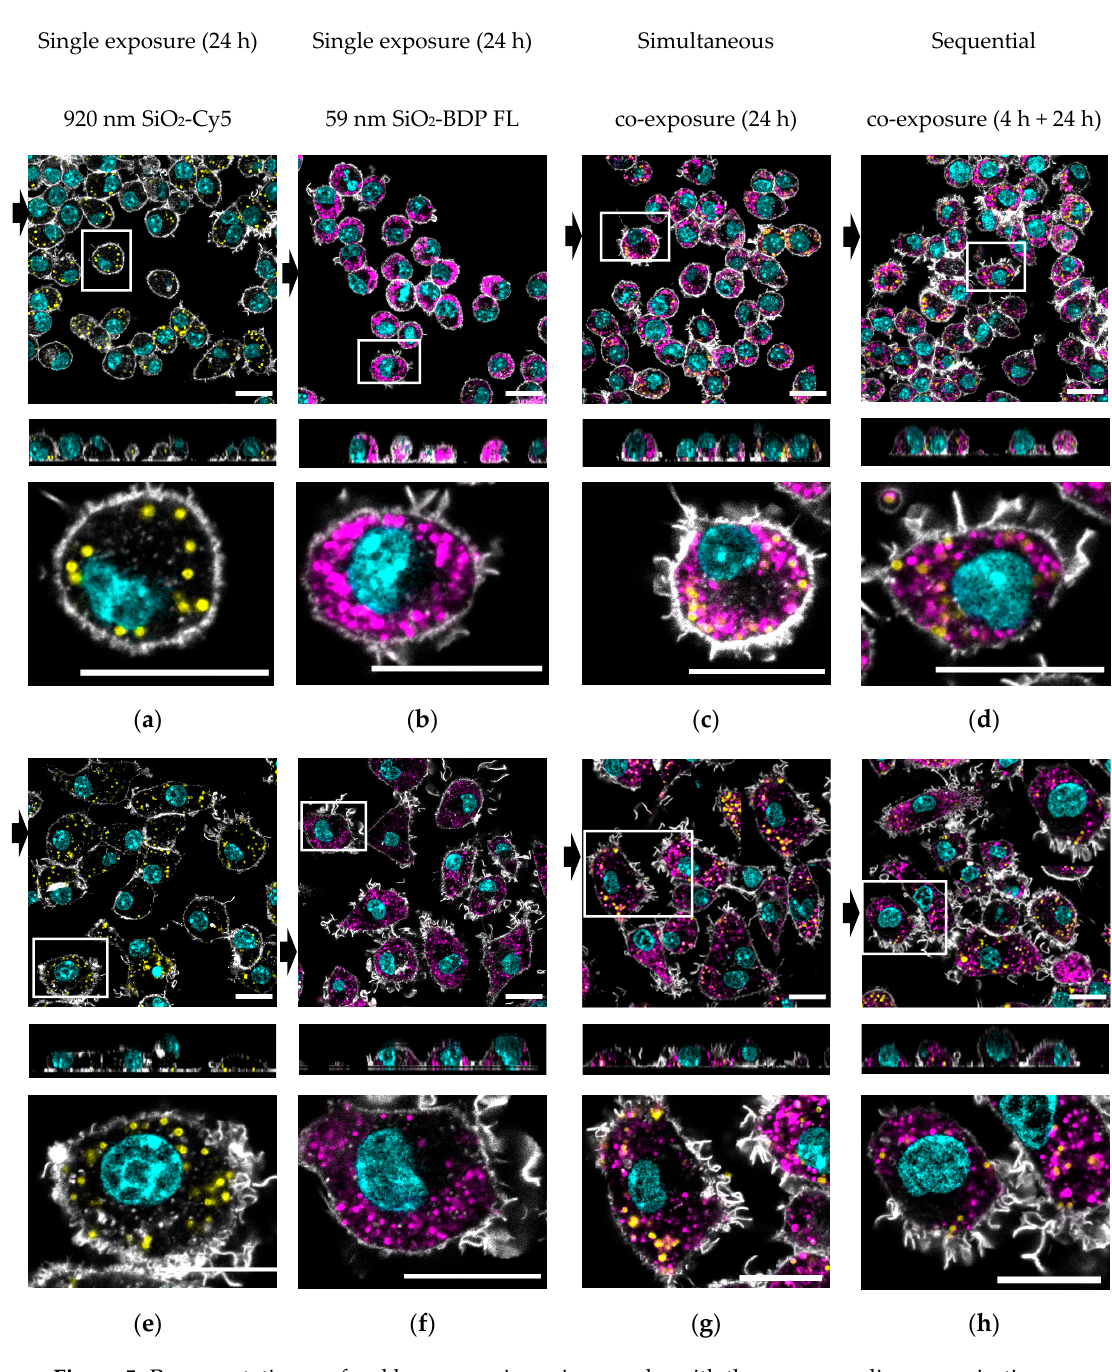
Figure 5. Representative confocal laser scanning micrographs with the corresponding xz projections demonstrate the uptake of 59-nm SiO 2 -BDP FL NPs and 920-nm SiO 2 -Cy5 particles in J774A.1 macrophages. Upper panels ( a – d ): Cells exposed to single 920-nm SiO 2 -Cy5 particles (yellow), single 59-nm SiO 2 -BDP FL NPs (magenta), or a combination of SiO 2 particles simultaneously for 24 h or sequentially for 4 h and 24 h. Bottom panels ( e – h ): Cells were prestimulated with 1-µg/mL LPS for 24 h and then post-exposed to single 920-nm SiO 2 -Cy5 particles, single 59-nm SiO 2 -BDP FL NPs, or a combination of both particles simultaneously for 24 h and sequentially for 4 h and 24 h. F-actin was stained as the cytoskeleton marker using a rhodamine-phalloidin conjugate (grey), and the nucleus was stained using 4 ′ ,6-diamidino-2-phenylindole (DAPI) (cyan). The black arrows represent the position of the xz projection (at the bottom), showing the intracellular localization of the particles. Zoom-in images (shown under each representative image) clearly demonstrate the cellular distribution of two types of SiO 2 particles. Scale bar: 20 µM.